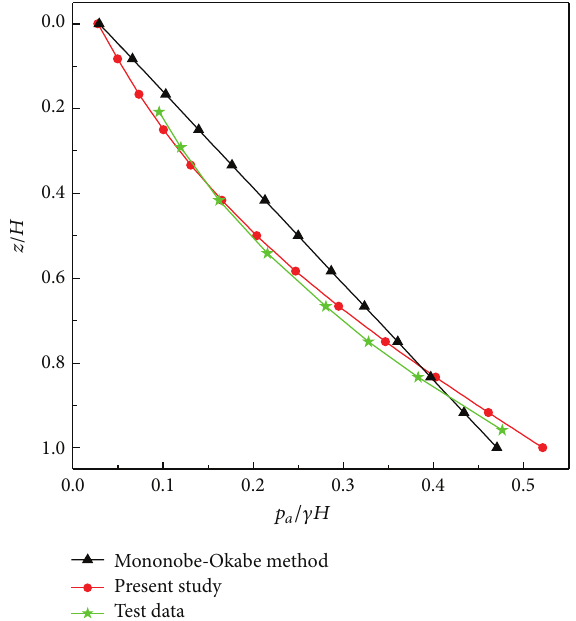
Figure 10: Typical comparison results for 𝑘 ℎ = 0.04 , 𝑘 𝑉 = 0.02 , 𝜑 = 22.3 ∘ , 𝛽 = 11.1 ∘ , and 𝛾 = 18.8 kN/m 3 .